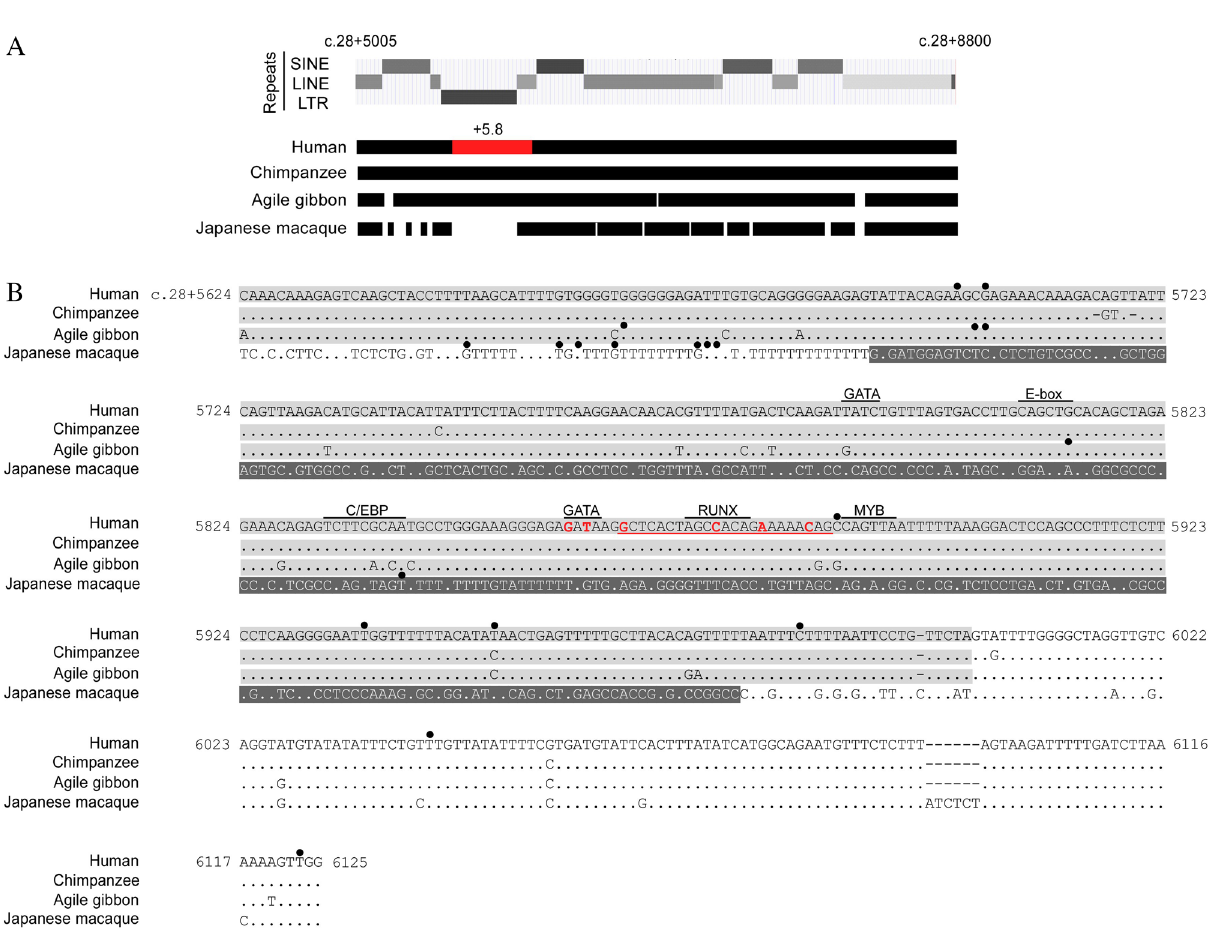
Figure 2. Comparison of nucleotide sequences in the first intron of ABO involving the human + 5.8-kb site and the corresponding regions in chimpanzee, gibbon, and Japanese macaque. ( A ) Comparison of nucleotide sequences in the first intron of ABO among human, chimpanzee, gibbon, and Japanese macaque. The top line shows the nucleotide sequence of the first intron in human ABO from c.28 + 5005 to c.28 + 8800, and the + 5.8- kb site in human ABO is denoted in red. The other lines represent the nucleotide sequences in chimpanzee, gibbon, and Japanese macaque corresponding to the human genome. Retrotransposons in the human genome are denoted over those lines for human and non-human primates. ( B ) Comparison of nucleotide sequences between the human + 5.8-kb site and the corresponding sites found in non-human primates. The top line shows the nucleotide sequence of the + 5.8-kb site in human ABO from c.28 + 5624 to c.28 + 6125, and the other lines represent the nucleotide sequences of the sites corresponding to the human + 5.8-kb site from chimpanzee, gibbon, and Japanese macaque. The sequences were deposited in GenBank with accession numbers OP775662 (chimpanzee), OP775663 (gibbon), and OP775664 (Japanese macaque). Nucleotides that are red or underlined indicate single nucleotide variants (SNVs) or deletion in individuals with weak phenotypes such as A m , A 3 , B m and B 3 . The motifs for transcription factor recognition sites are indicated by overbars. For comparison with the nucleotides in human ABO , the substituted nucleotides are shown and horizontal bars denote deletion of nucleotides in those monkeys. Solid circles over nucleotides in the human and monkey sequences indicate single nucleotide polymorphisms (SNPs) or variants. Nucleotide sequences belonging to LTR are highlighted in gray, and those belonging to SINE are highlighted in dark